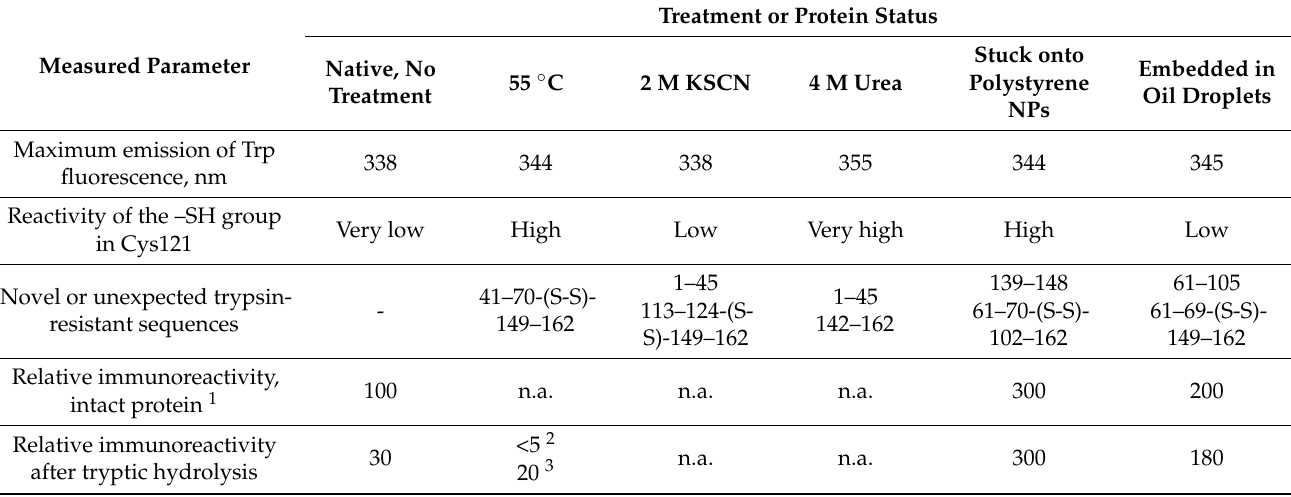
Figure 4. A schematic of the different types of BLG denaturation in oil–water emulsions and on the surface of hydrophobic NPs. The orientation of individual elements of the BLG structure was inferred from molecular dynamics and limited proteolysis studies [23,45]. Table 1. Features of the BLG conformers generated by physical and chemical denaturation or by adhesion to